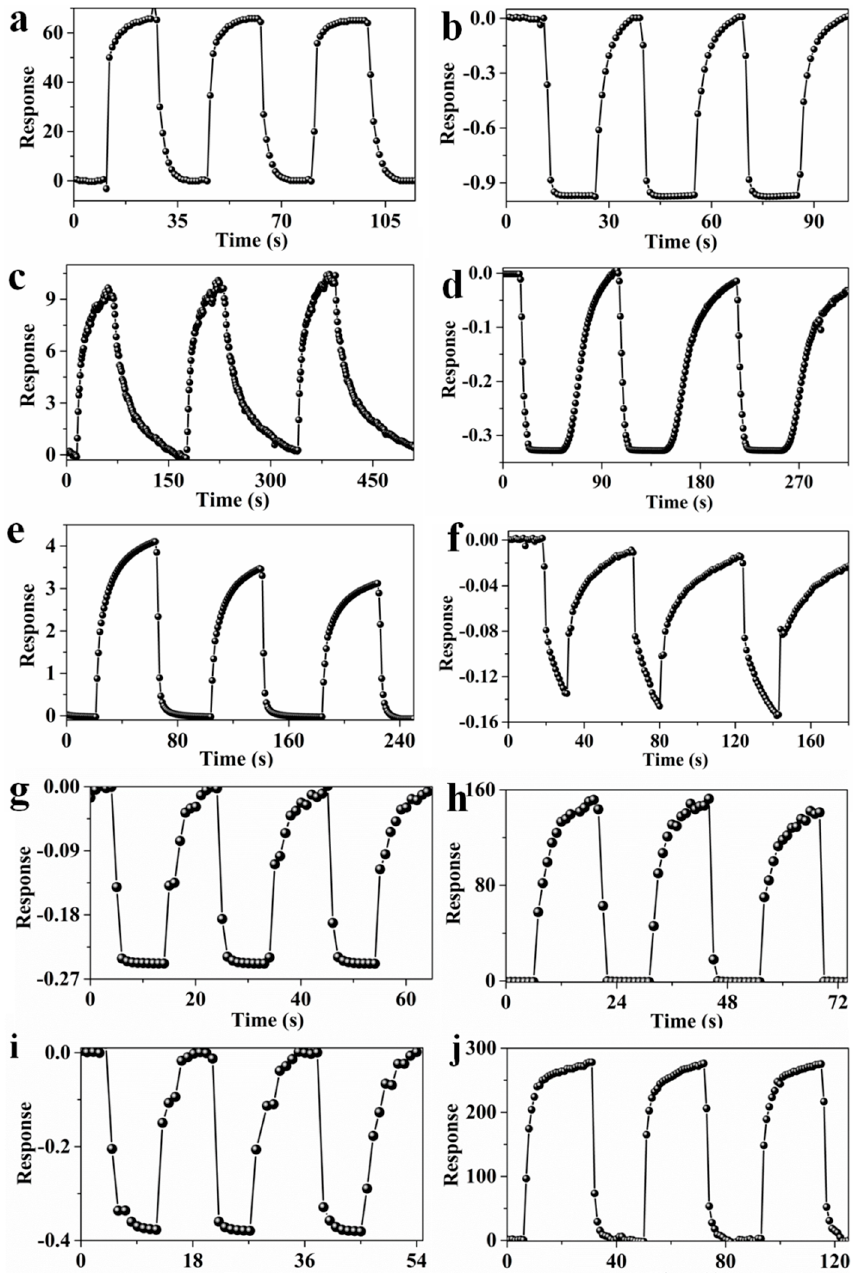
Figure 4. Response curves of p-PANI/CNT to 50 ppm of ( a ) NO 2 , ( b ) NH 3 ; Response curves of p-PANI to 50 ppm of ( c ) NO 2 , ( d ) NH 3 ; Response curves of MWCNTs to 50 ppm of ( e ) NO 2 , ( f ) NH 3 ; Response curves of n-PANI to 50 ppm of ( g ) NO 2 , ( h ) NH 3 ; Response curves of n-PANI/CNT to 50 ppm of ( i ) NO 2 , ( j ) NH 3 .